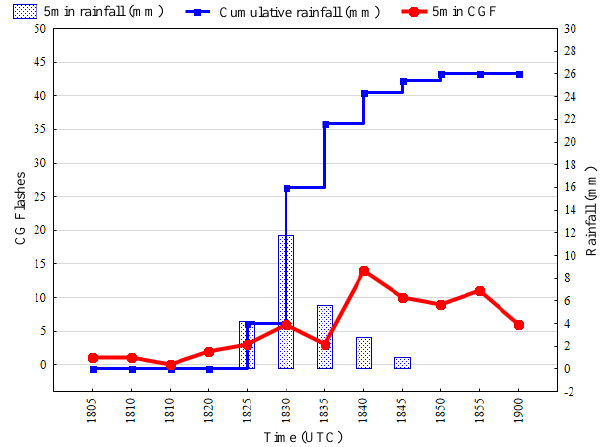
Figure 7. Critical interval time series for debris flow event of 7 Au- gust 1996. This is an event from the STH group and debris flow initiation was observed at 19:00UTC.